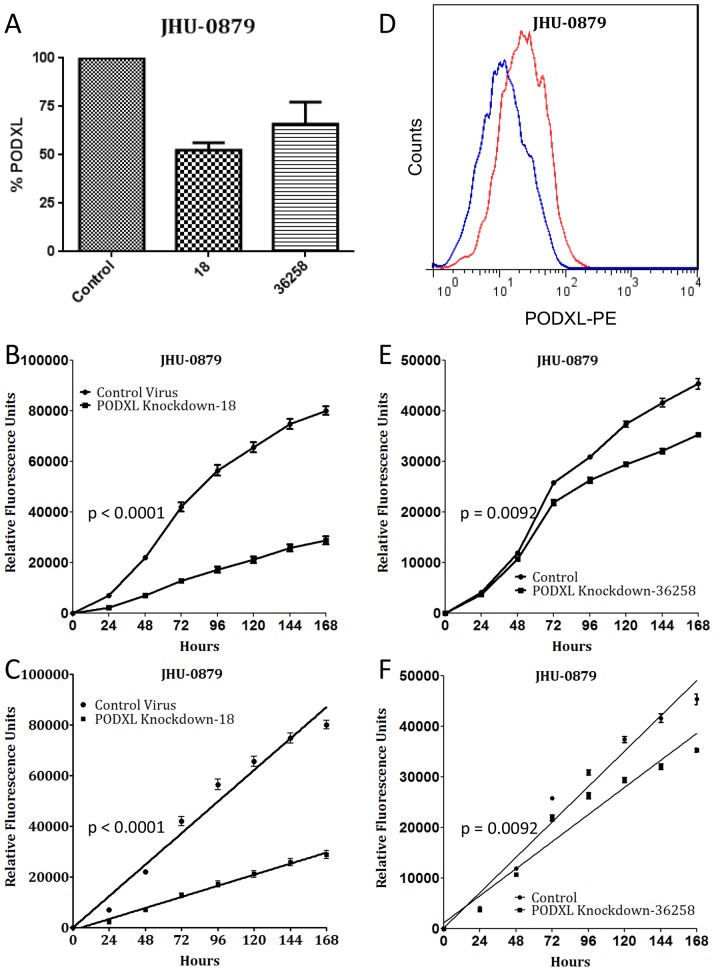
Knockdown of PODXL expression correlates with decreased cell proliferation.(A): Lentiviral knockdown of PODXL expression, as assayed by flow cytometry, using the two shRNA sequences utilized for functional studies. (B): Representative growth curve of PODXL knockdown with TRCN0000117018 and control knockdown in JHU-0879 cells over 7 days and (C) the linear regression fit of the growth curves (p<0.0001). Quantitatively similar results were obtained with each replicate. (D): Analytical flow cytometry histogram of JHU-0879 cells transduced with either control virus (red) or TRCN0000117018 virus (blue), demonstrating the knockdown of PODXL expression. (E): Representative growth curve of PODXL knockdown with V2THS_36258 and control knockdown in JHU-0879 cells over 7 days and (F) the linear regression fit of the growth curves (p = 0.0092). Quantitatively similar results were obtained with each replicate.